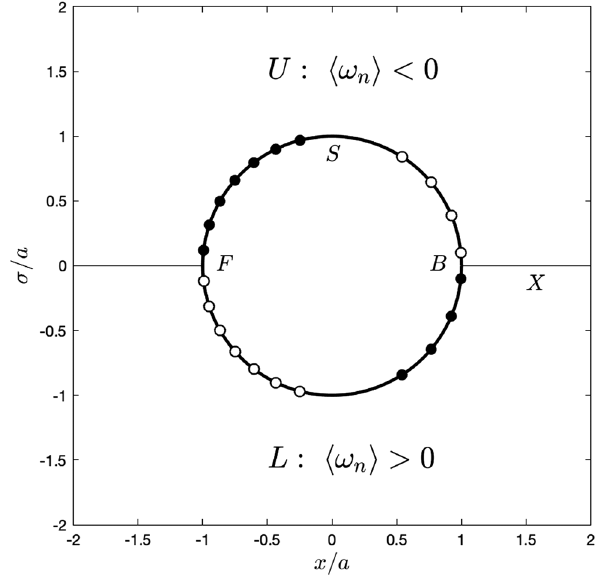
FIG. 5. Schematic of azimuthal vorticity generation on the surface of the sphere. Following the convention of Huggins [16], we use white circles to denote vorticity out of the plane ( ω and black circles to denote vorticity into the plane ( ω mean normal (azimuthal) vorticity in the upper half plane U is negative and the mean normal (antiazimuthal) vorticity in the lower half plane L is positive, implying a pole-to-pole asymmetry in the pressure distribution on the surface S of the sphere. The pressure drop along the surface of the sphere from F to B is exactly compensated by the pressure rise from B to infinity along the direction of the positive streamwise axis X